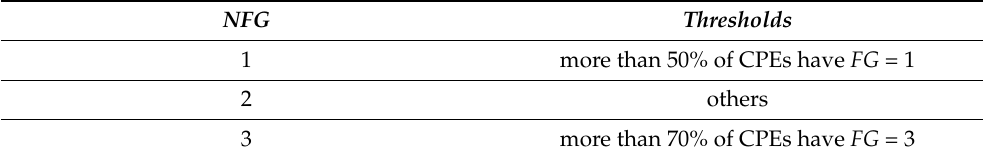
Table 7. Thresholds for the performance grade of non-intelligent devices.